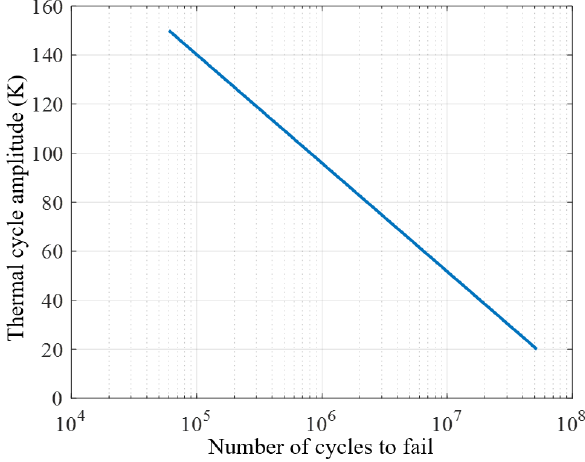
Figure 3. Number of cycles to failure versus temperature variation of a MOSFET die in a power module for automotive applications, as shown in Reference [17].